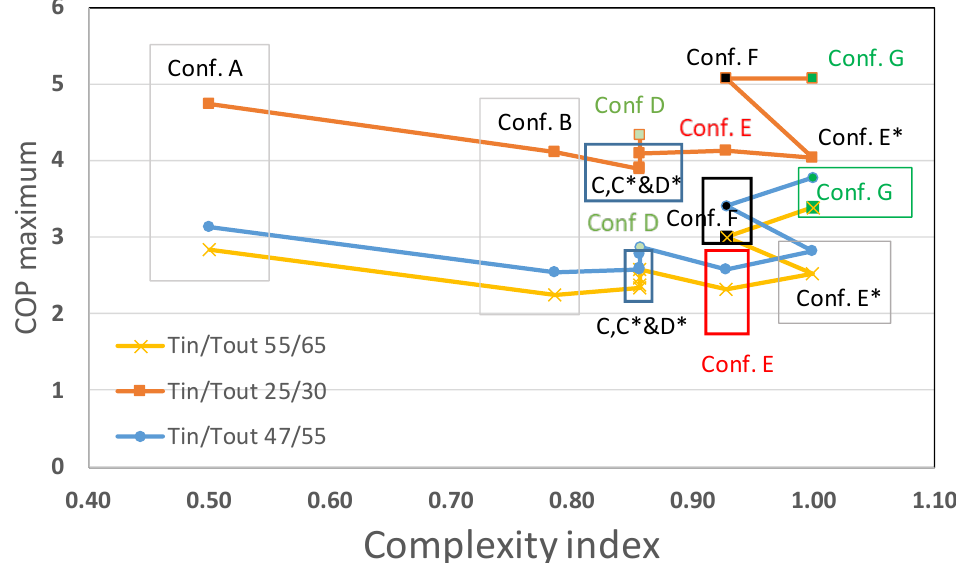
Figure 10. Maximum COP as a function of complexity index for space heating applications (47 °C/55 °C and 55 °C/65 °C) as well as for swimming pool water heating applications (25 °C/30 °C).